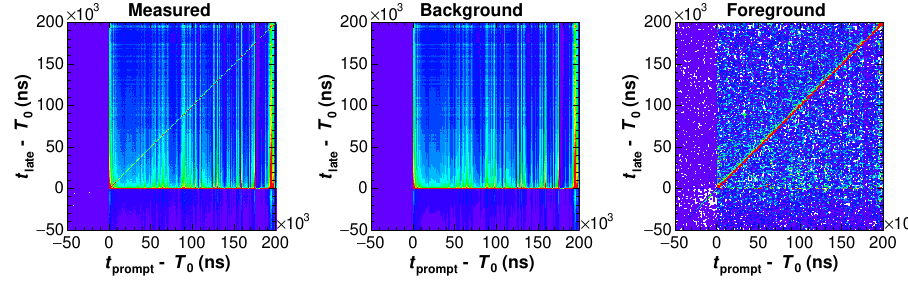
Figure 3. Measured t late vs t prompt spectrum (left), the estimated accidental background (middle), and the residuum of both